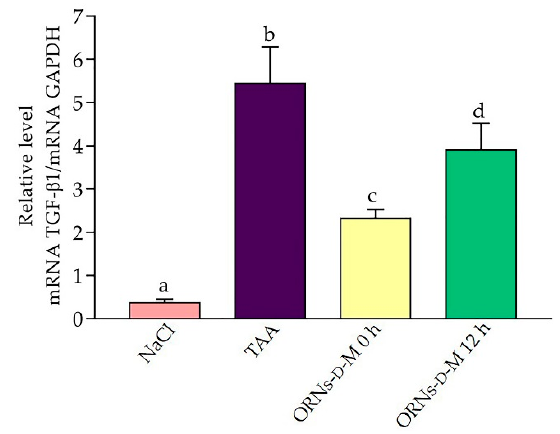
Figure 5. Effect of ORNs- D -M on the expression of TGF- β 1 mRNA in TAA-induced liver damage mice. The investigated mRNA levels were normalized to GAPDH as a control. Data are presented as the mean ± SD, n = 6 for each group. Values marked with different letters (a, b, c, d) are statistically different, p < 0.05 (Student’s t -test). Abbreviations: NaCl—control mice receiving a single injection of NaCl; TAA—mice receiving a single injection of TAA; ORNs- D -M 0 h—mice receiving a TAA and ORNs- D -M immediately after TAA application (i.e., 0 h) and every next 12 h for 48 h; ORNs- D -M 12